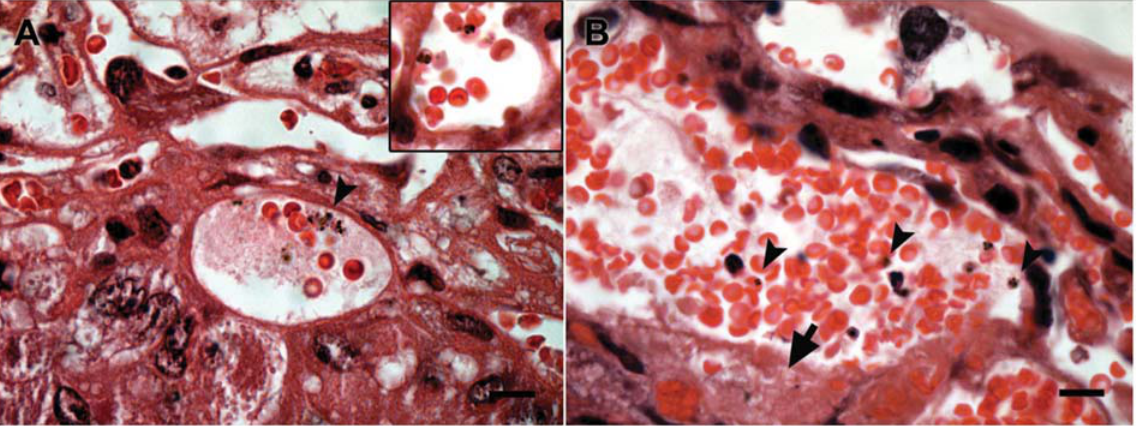
Figure 7. Occasional placenta pathology in non-recrudescent pregnant females. Photomicrographs of HE-stained placental sections of sporadic cases of placental pathology in non-recrudescent females. The figure shows presence of iRBC adhered to the syncytiotrophoblast layer (A, insert) and in blood sinusoids (arrowheads) as well as trophoblast thickening (arrow). Scale bar represents 15 m m.